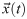
All interactions allowed in the simulation.Replicase (R) can form a complex with other replicase (R) or with parasite (P) at aR rate. A replicase-replicase (RR) or replicase-parasite (RP) complex can produce new entity (replicase in a case of RR and a parasite in the situation of RP) at rate K. Parasites and replicases can move at rate D and decay at rate b. Vector x→(t) denotes the agent’s position and vector x→(t+dt) denotes its position in the next step.